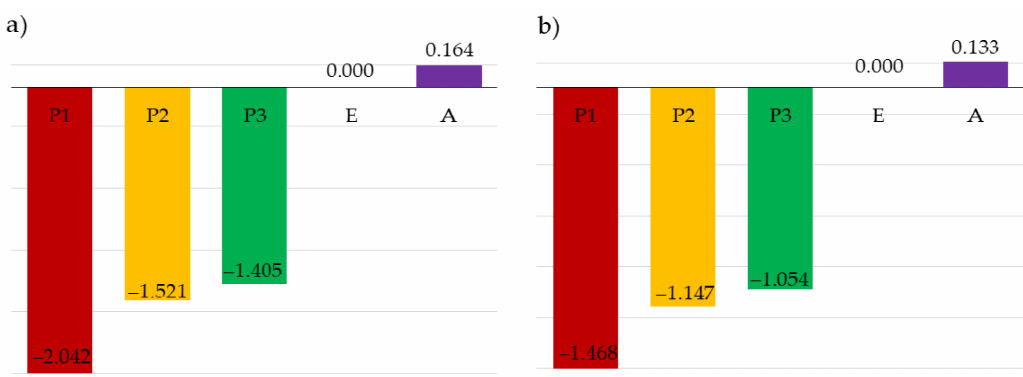
Figure 11. Elasticity index for ULS: ( a ) Case 1, ( b ) Case 2.